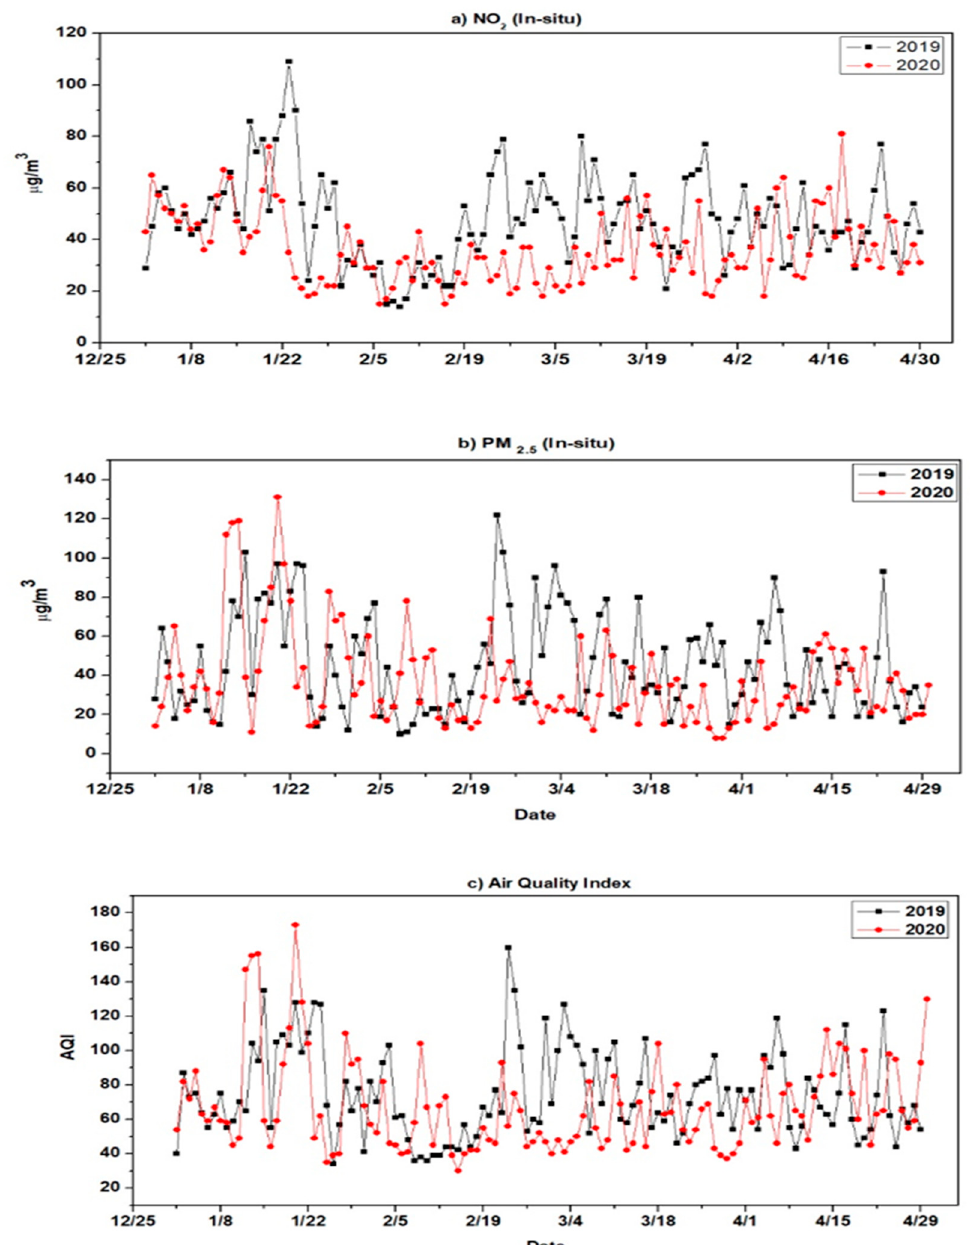
Figure 4. Time series of in situ measurements for ( a ) nitrogen dioxide (NO 2 ), ( b ) particulate matter (PM 2.5 ) and ( c ) the air quality index (AQI) over the study area from January to April during 2019 and 2020.